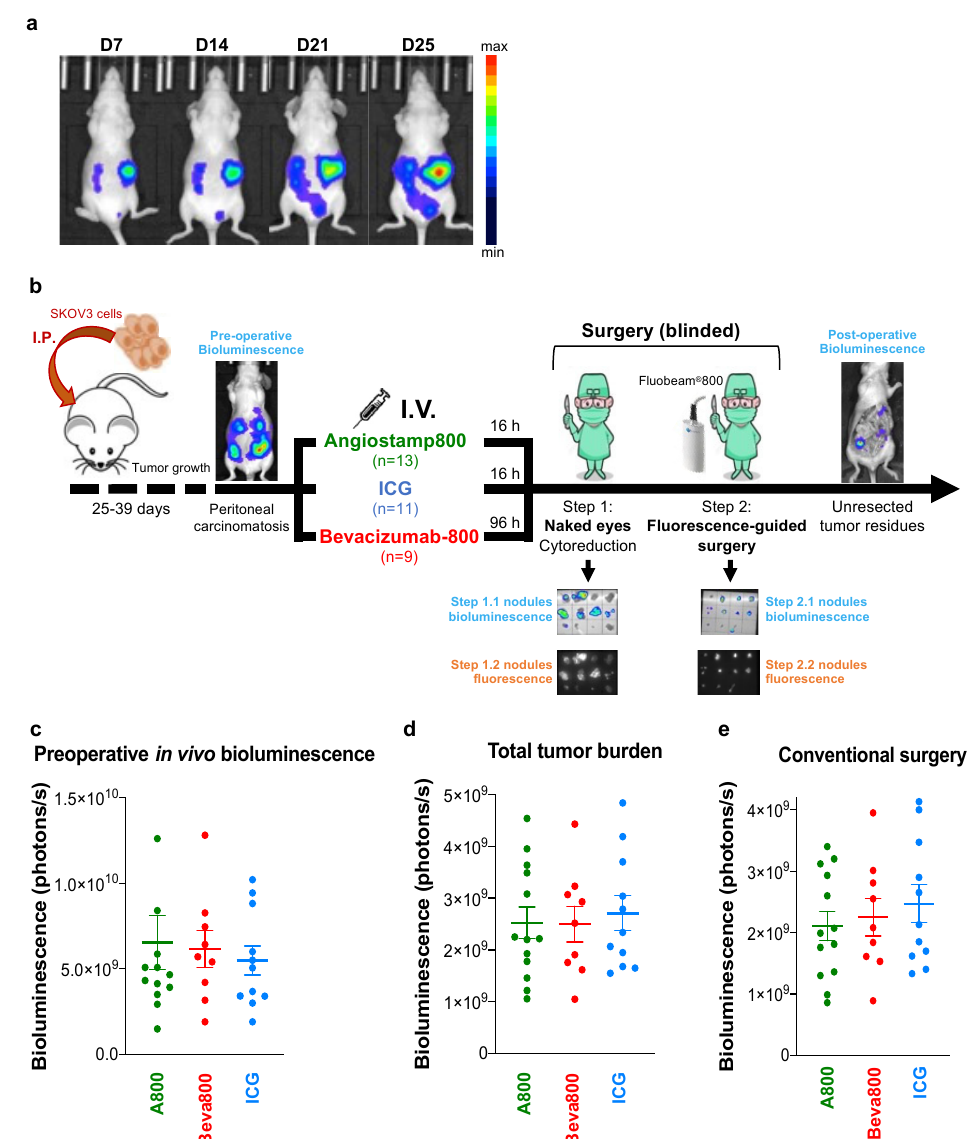
Figure 1. Conventional surgery for peritoneal carcinomatosis. ( a ): Orthotopic murine model of peritoneal carcinomatosis from ovarian cancer. Mice were inoculated with SKOV3-Luc cells intraperi- toneally. Tumor growth and dissemination of tumor cells in the peritoneal cavity were followed by in vivo bioluminescence imaging over time. ( b ): Schematic representation of orthotopic peritoneal carcinomatosis murine model, blinded surgery plan, and surgical nodules analysis. Tumor loads resected at each step and the unresected tumor residues left in the mouse body were evaluated by ex vivo bioluminescence imaging of the surgical specimens and the mouse abdominal cavity, re- spectively. ( c ): In vivo noninvasive bioluminescence in mice with established orthotopic peritoneal carcinomatosis from ovarian cancer showed no significant difference between the groups. ( d ): The total tumor burden is the sum of ex vivo bioluminescence signals of tumor nodules resected by conventional and fluorescence-guided surgery and residual tumor nodules left in mice. No signifi- cant differences were observed between the groups. ( e ): Bioluminescence signal of tumor nodules resected by conventional surgery in mice showed no significant difference between the groups. ( d– e ): Each dot represents one mouse. Bars, mean ± SEM.